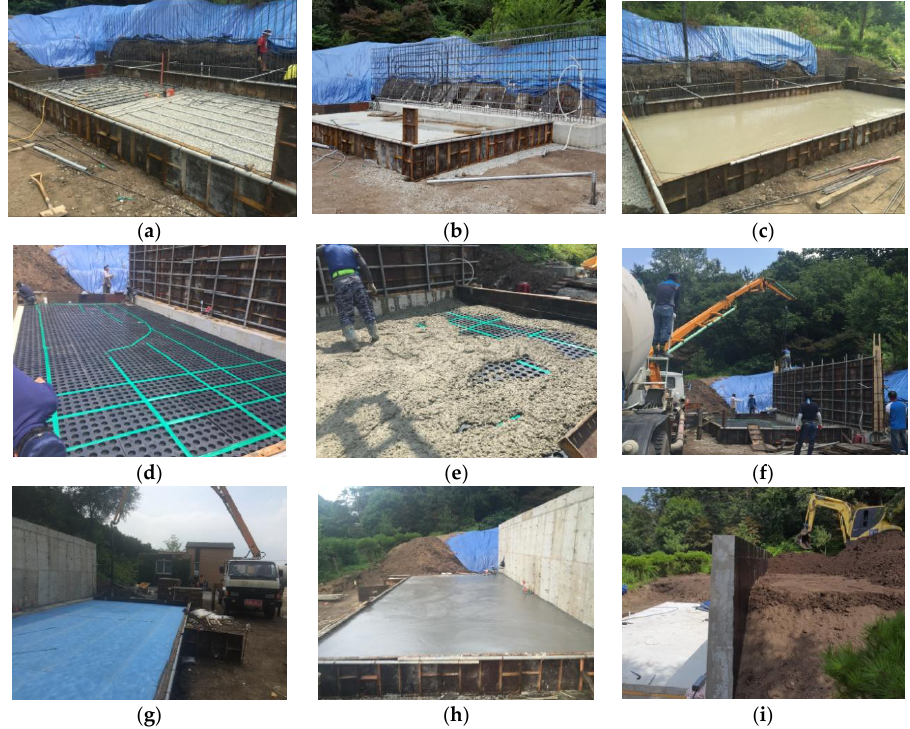
Figure 5. Comprehensive procedure of energy slab construction. ( a ) Installation of the heat exchange pipe; ( b ) Steel reinforcement and mold assembly; ( c ) Cast-in-place of bottom floor slab; ( d ) Installation of drain board; ( e ) Cast-in-place of floor slab; ( f ) Cast-in-place of wall slab; ( g ) Installation of thermal insulation layer; ( h ) Finishing work of the energy slab; ( i ) Sand backfilling.